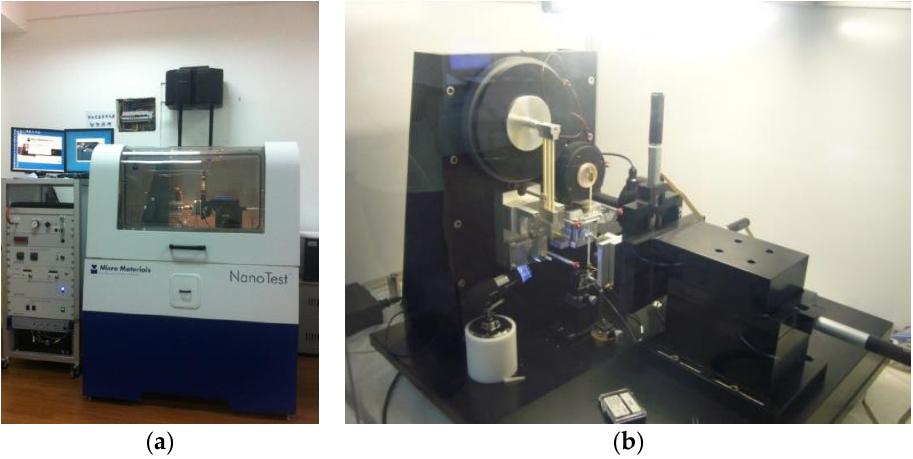
Figure 2. NanoTest Vantage testing system [16]: ( a ) appearance; and ( b ) internal details.